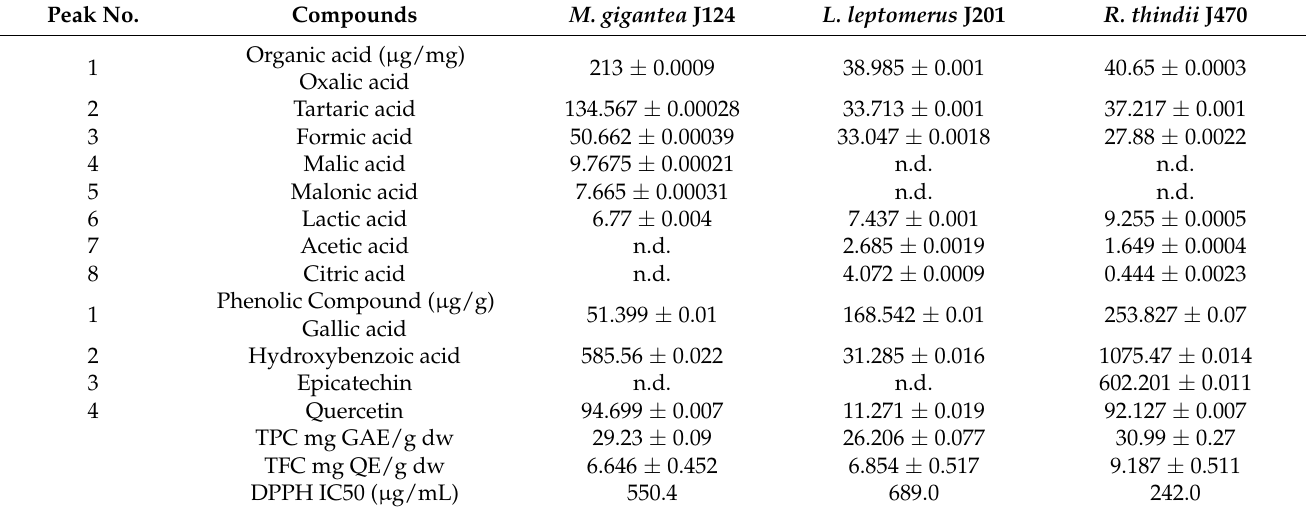
Table 4. Organic acid and phenolic compound, total phenolic, total flavonoid and DPPH IC50 of the three wild edible